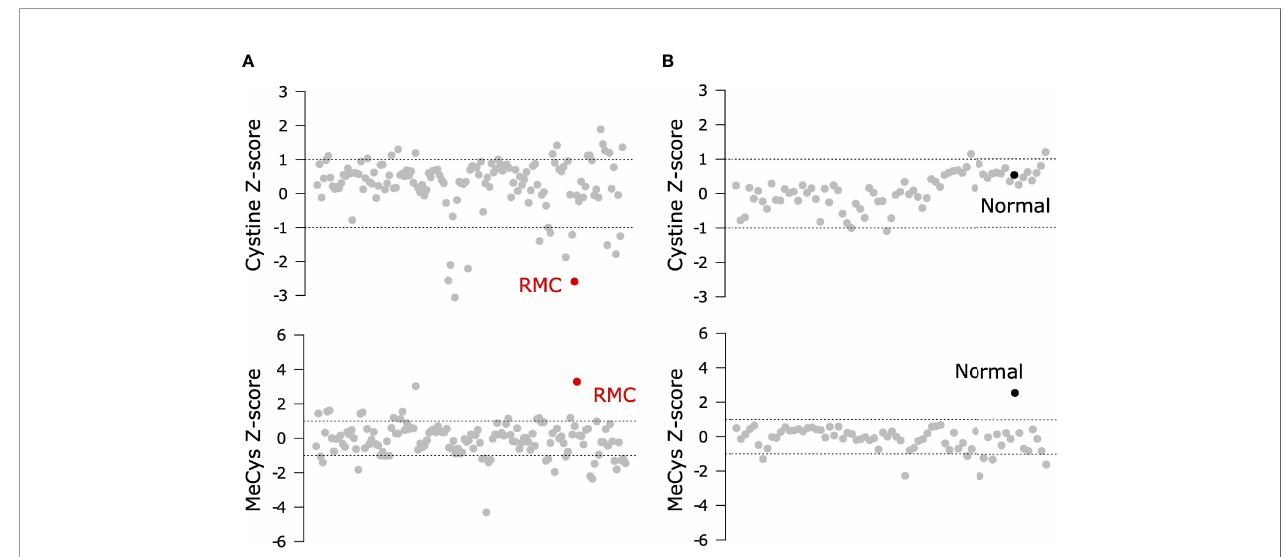
FIGURE 3 | Signals of increased cystine uptake in the RMC primary tumor. (A) Z-scores for cystine and MeCys from RMC tumor tissue sample (red) on a background of ccRCC tumor samples (grey). (B) Z-scores for cystine and MeCys from normal tissue sample (black) adjacent to an RMC tumor on a background normal tissue (grey) adjacent to ccRCC tumor samples. Dotted lines represent one standard deviation away from the